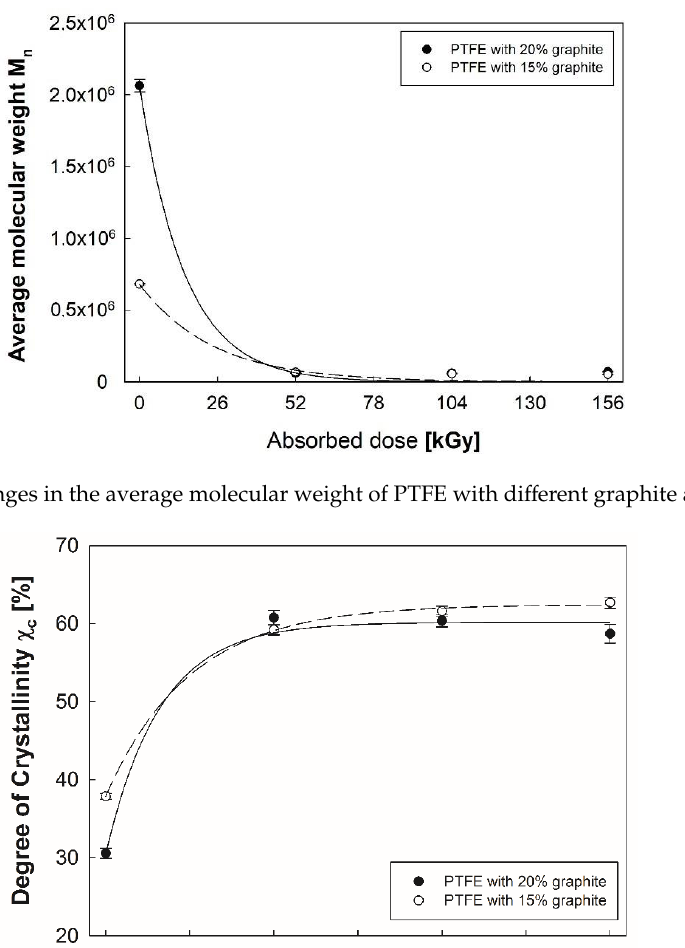
Figure 4. Changes in the crystallinity of PTFE with 15% and 20% graphite addition.